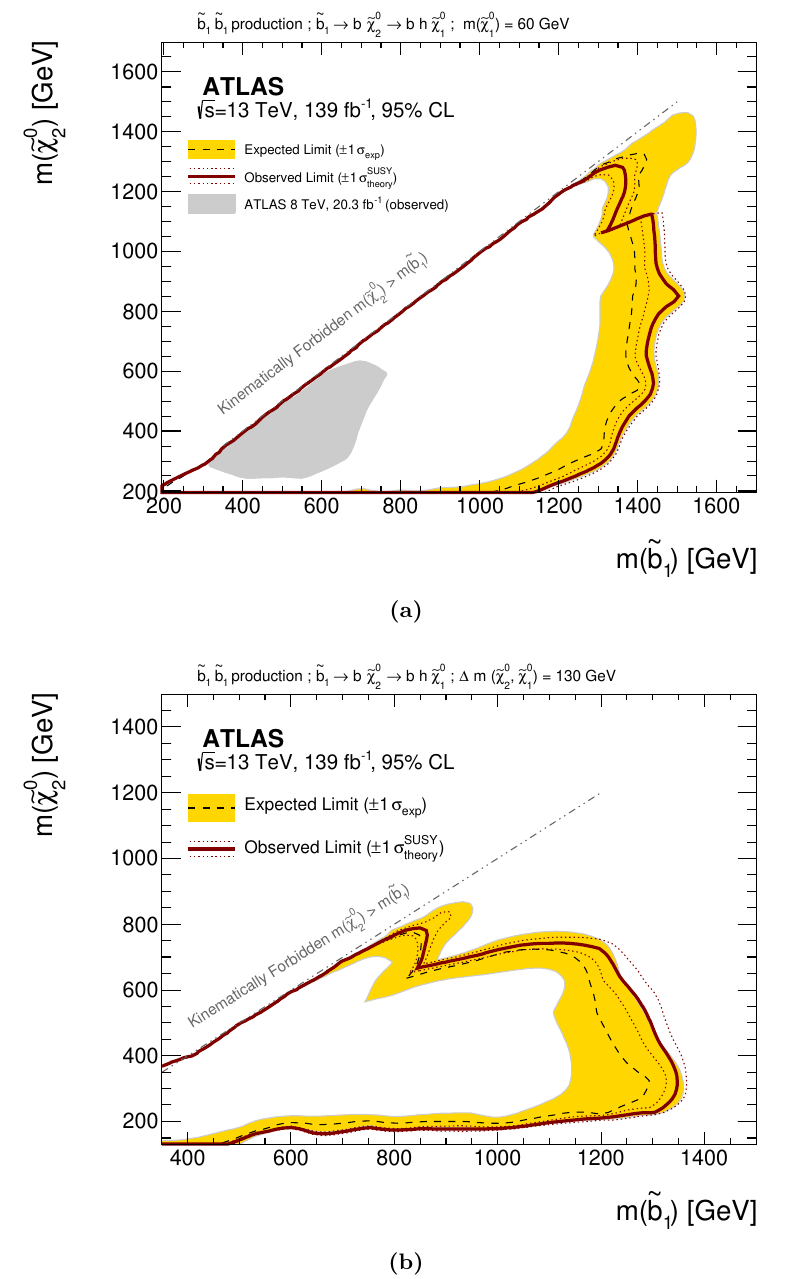
0 ) phase space for (a) the m (~ (cid:31) 0 ) = 1 ; ~ (cid:31) 2 1 ; ~ (cid:31) 0 ) = 130 GeV 2 1